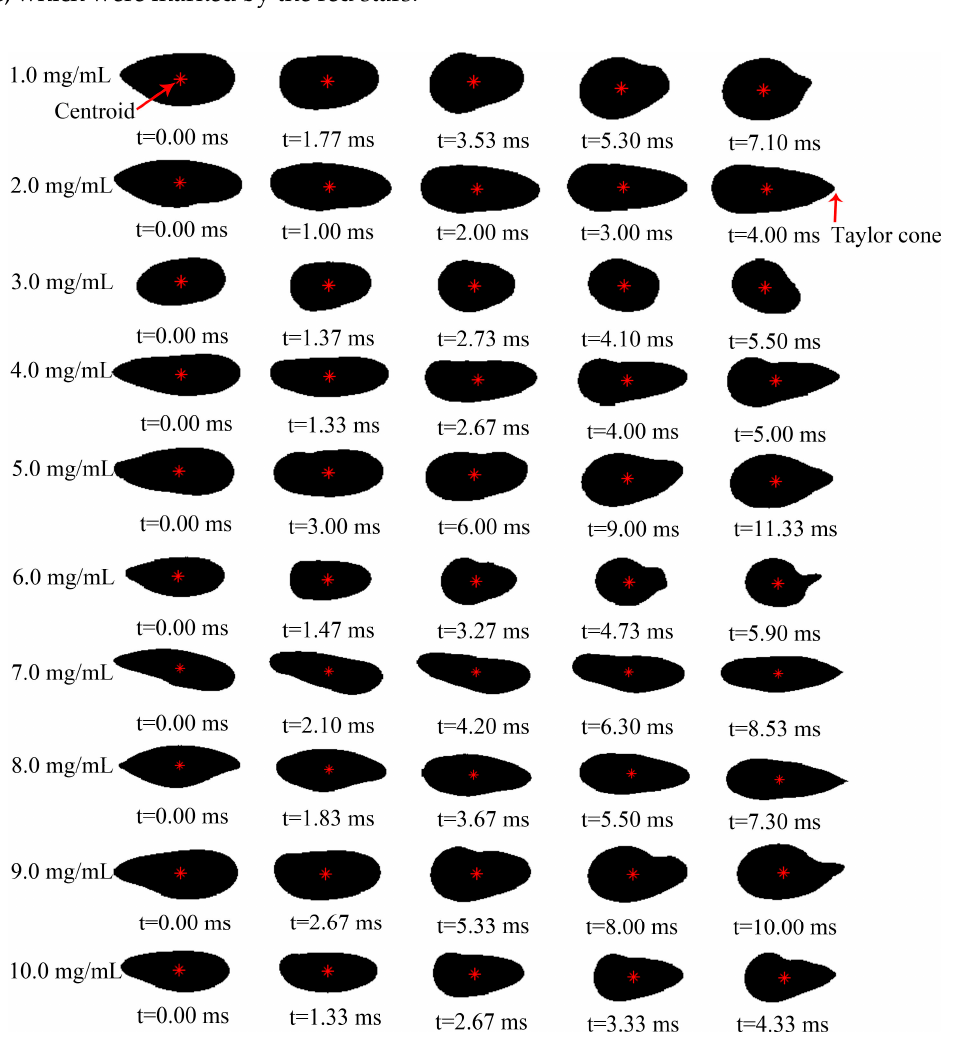
Figure 2. Formation of Taylor cones. Table 1. The formation time and the angles of Taylor cones at different concentrations.